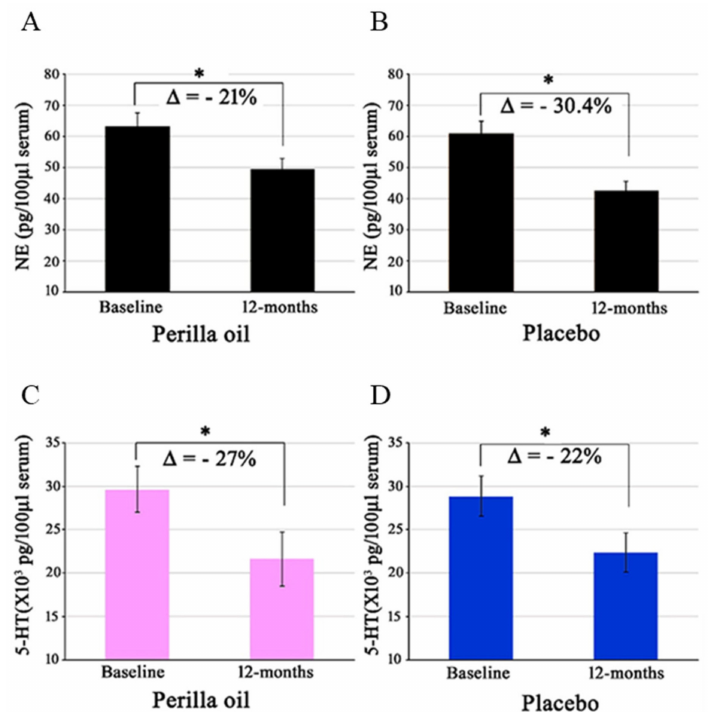
Figure 3. E ff ect of PO administration on serum norepinephrine (NE) and serotonin (5-HT) levels. There were no inter-group di ff erences, but significant intra-group decreases in serum levels of NE ( A , B ) and serotonin ( C , D ) were noted in both PO and placebo groups. ∆ = Changes from baseline to 12 months. Placebo, n = 34. Perilla oil, n = 31, * p <